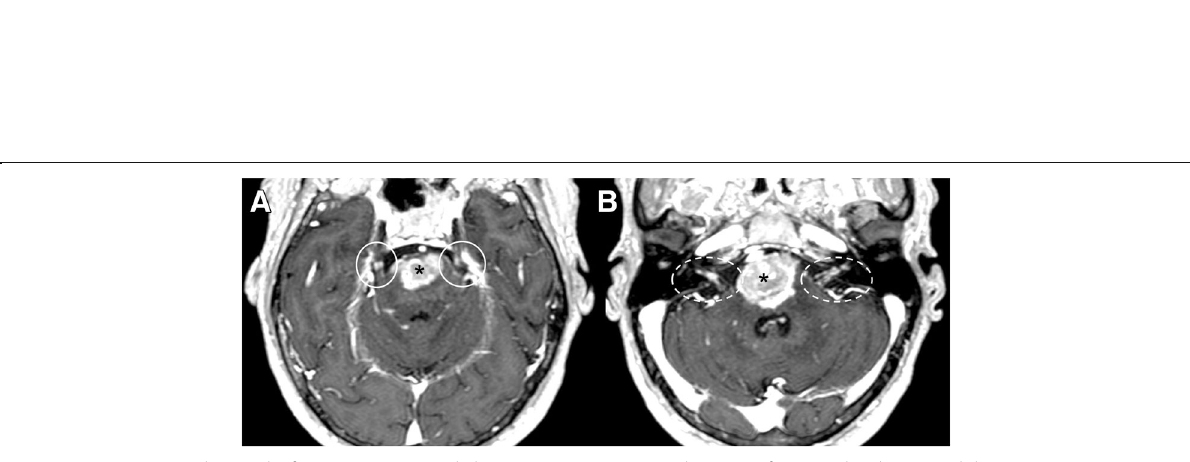
Fig. 22 Leptomeningeal spread of tumor. Patient with lung carcinoma. MRI axial image of T1-weighted post-gadolinium sequence demonstrates a large metastasis of the pons (asterisks), bilateral leptomeningeal enhancement of trigeminal nerves ( a , circles), and bilateral facial and vestibulocochlear nerves ( b , dotted circles)